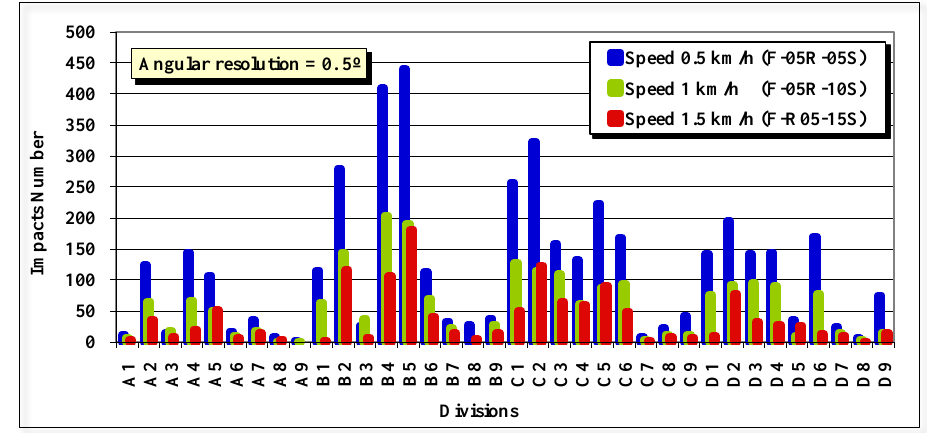
Figure 10. Impacts of scans F-05A-05S, F-05A-10S and F-05A-15S with angular resolution of 0.5°, and respective speeds of 0.5, 1.0 and 1.5 km/h.